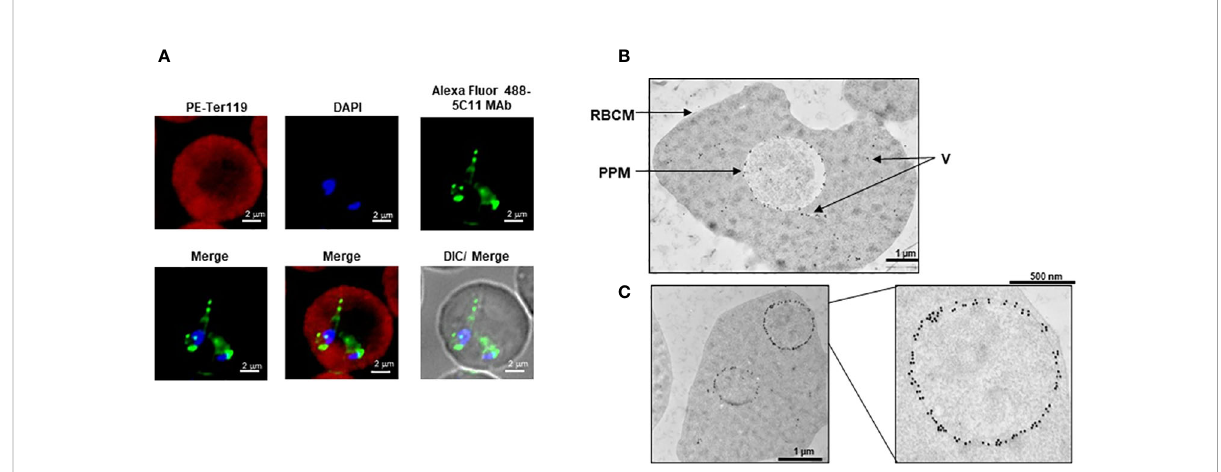
FIGURE 2 Subcellular localization of BmGPI12. (A) Immuno fl uorescence staining of BmGPI12 using 5C11 monoclonal antibody (raised in mouse) followed by staining with Alexa Fluor (AF)-488 conjugated anti-rabbit secondary antibody (AF488-BmGPI12 pAb, Green) in B microti -infected mouse RBCs (Bm-iRBC). Mouse RBCs were stained with Phycoerythrin (PE)-conjugated anti-mouse Ter 119 (PE-Ter119, Red). DAPI (Blue) was used to label parasite DNA. Bars, 2µm. (B, C) Transmission immunoelectron microscopic analysis of B microti LabS1 – infected mouse red blood cells (mRBCs). Ultrathin sections of high-pressure frozen and Durcupan resin – embedded infected RBCs were immunolabeled with anti-BmGPI12 monoclonal antibody (5C11) coupled to 10 nm gold particle. Portion of image (C) is magni fi ed to show enlarged parasite showing localization of BmGPI12 in the parasite plasma membrane (PPM). RBCM: red blood cell membrane; V, vesicles. Bars, 1µm and 500